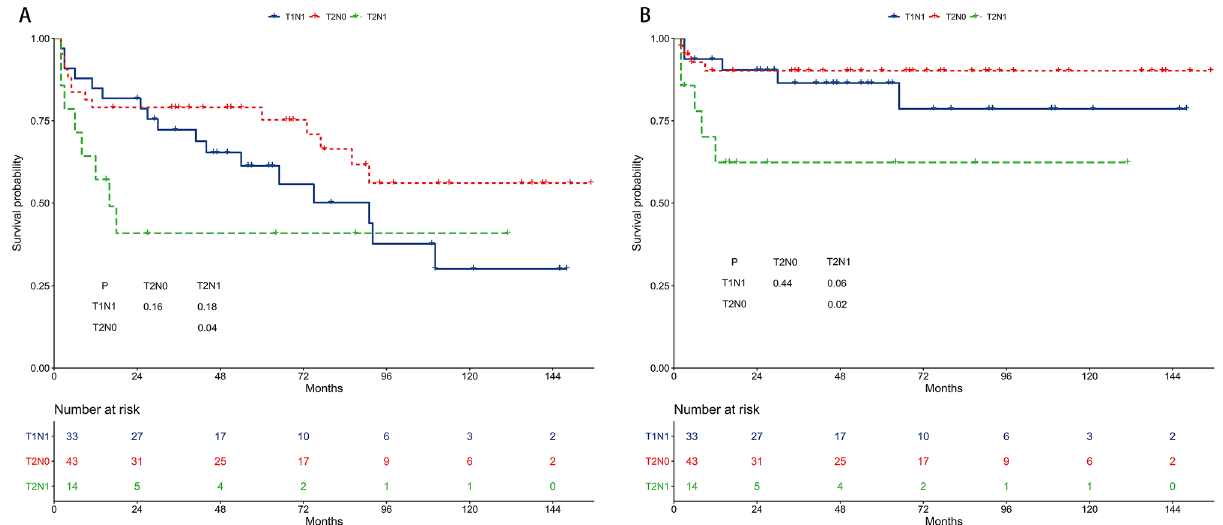
Figure 6. Survival outcomes of the T1N1, T2N0, and T2N1 subgroups in the radiotherapy group. ( A ) Overall survival. ( B ) Cancer-specific survival.